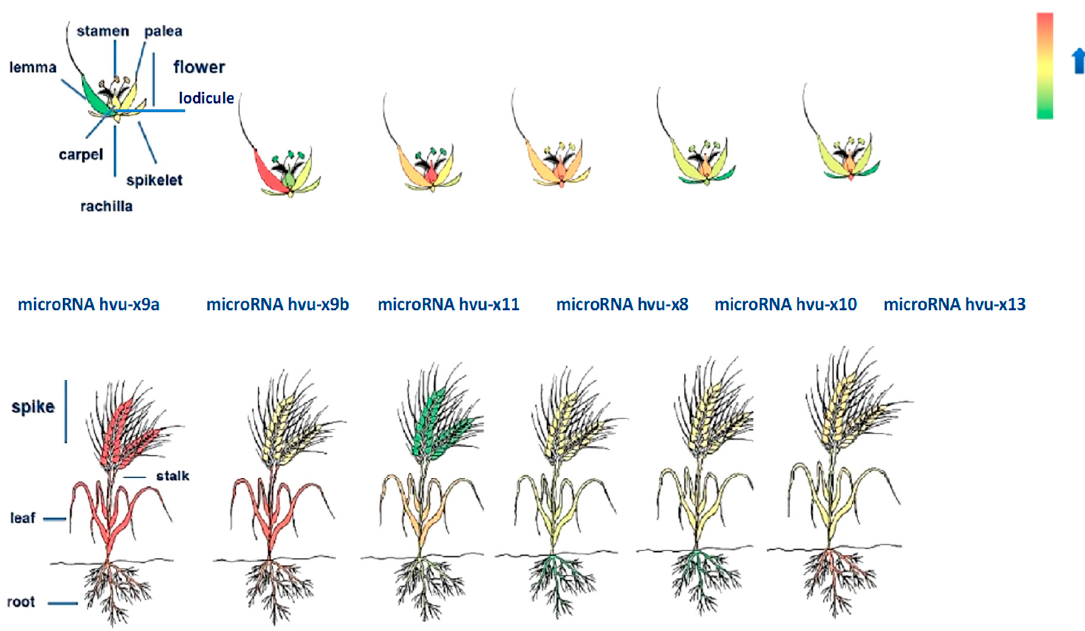
Figure 5. Expression pattern of novel microRNAs in barley organs. Heatmap represents expression level of novel microRNAs in particular barley organs. Red color indicates the highest expression while green represents the lowest. Top panel presents heatmaps for each novel microRNA in barley flower organs (lemma, palea, stamen, carpel, rachilla and lateral spikelets) and heatmap for microRNA hvu-x9a contains description of specific organs. Bottom panel represents expression of novel microRNAs in barley roots, leaf, stalk, and whole spike and heatmap for microRNAhvu-x9a contains description for particular organs. Above bottom panel names of each microRNA are provided.